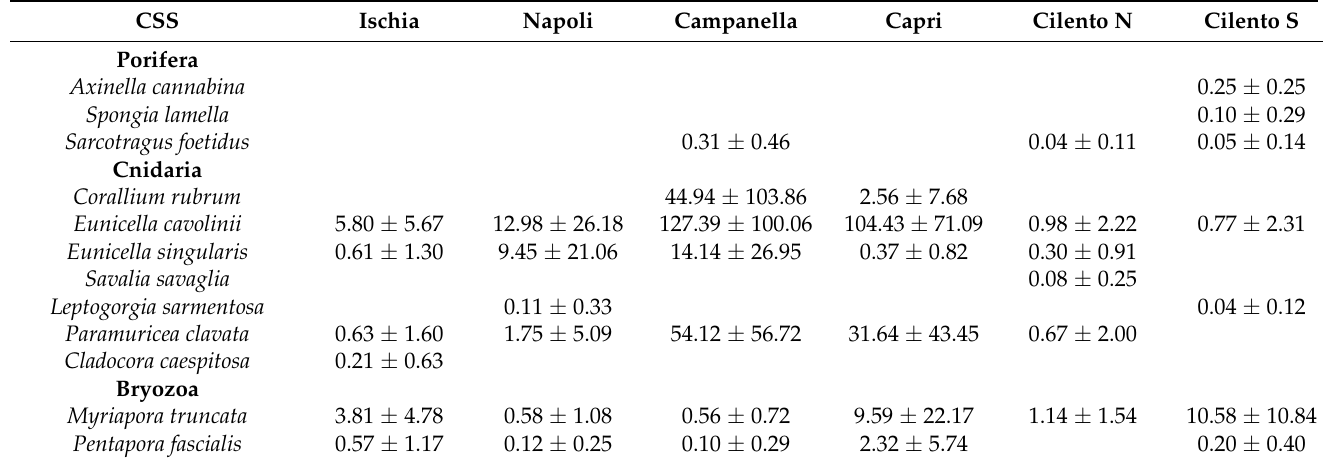
Table 1. Coralligenous structural species (CSS) densities, present in each investigated area and identified by ROV- imaging